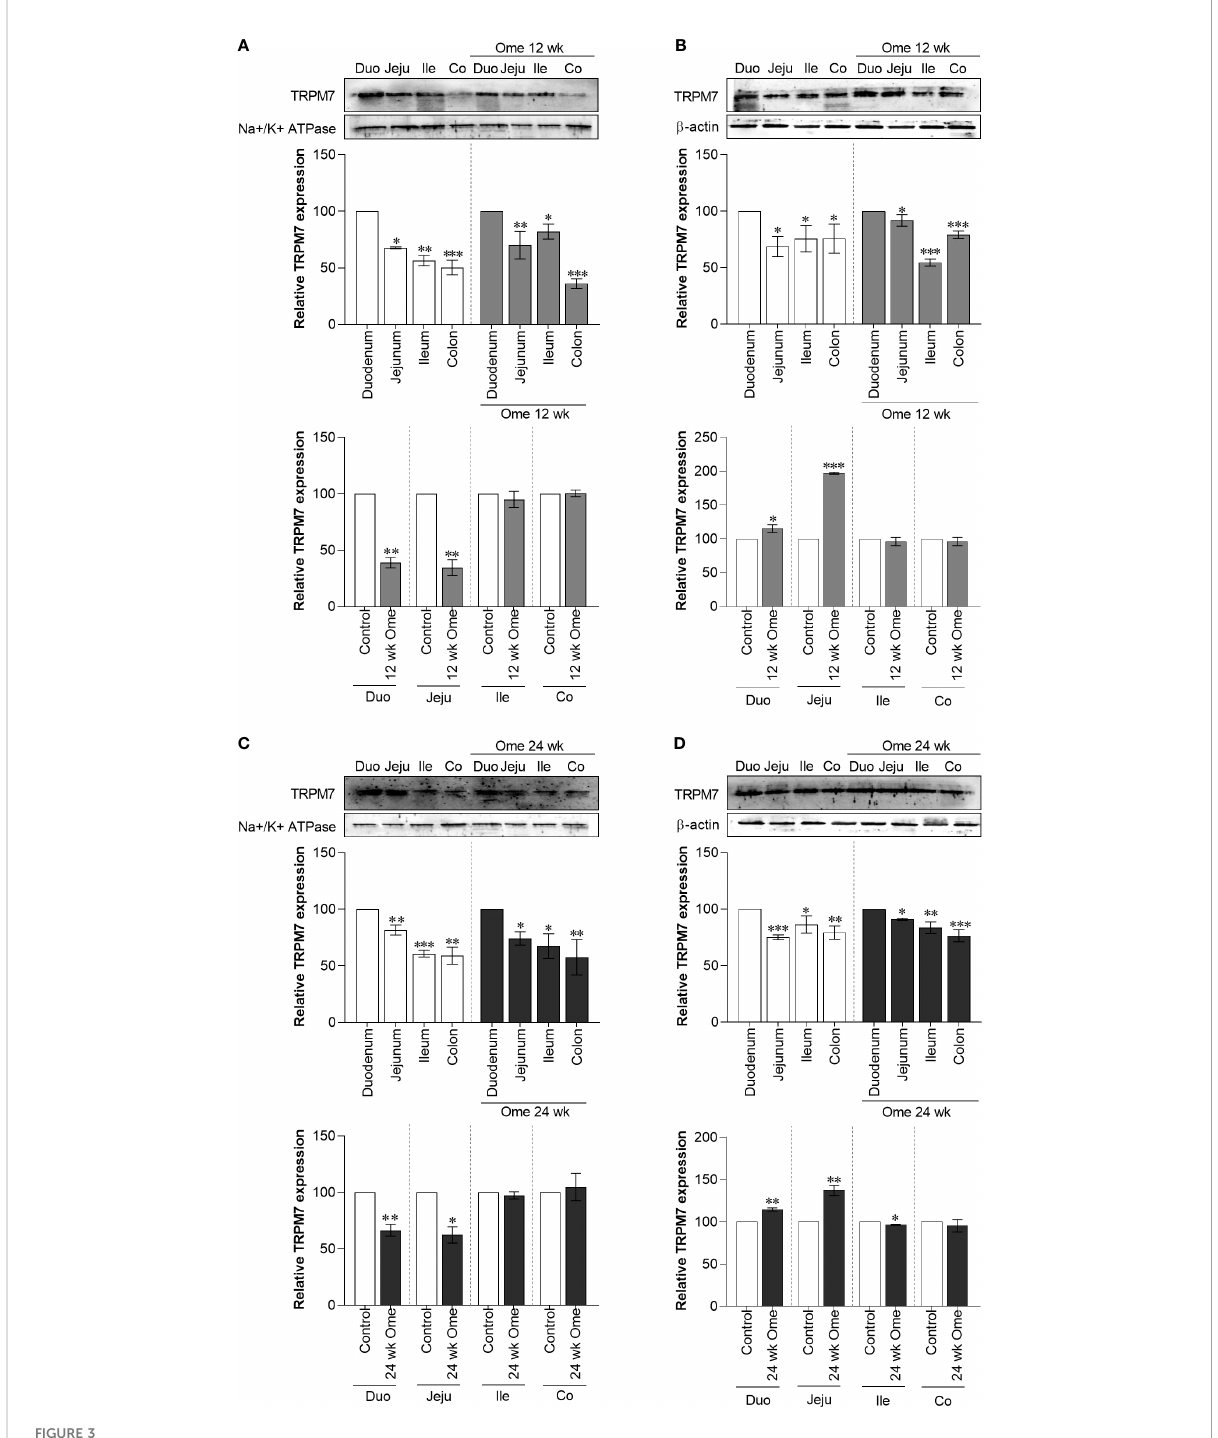
FIGURE 3 Membrane TRPM7 (A) and cytosolic TRPM7 (B) expression in duodenum, jejunum, ileum, and colon of control or 12 wk omeprazole-treated rats. Membrane TRPM7 (C) and cytosolic TRPM7 (D) expression in duodenum, jejunum, ileum, and colon of control or 24 wk omeprazole- treated rats. The upper relative expression graph; the protein expression in jejunum, ileum, and colon was relatively compared to that of in the duodenum. The lower relative expression graph; the protein expression in duodenum, jejunum, ileum, and colon of omeprazole-treated groups was relatively compared its corresponding segment of control group. Duo, duodenum; Jeju, jejunum; Ile, ileum; Co, colon; ome, omeprazole. * P < 0.05, ** P < 0.01, *** P < 0.001. ( n =